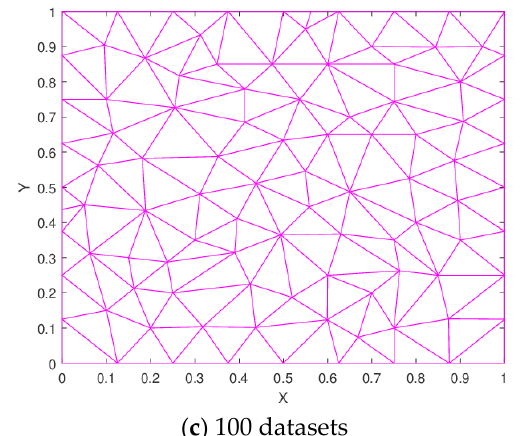
Figure 8. Delaunay triangulation.